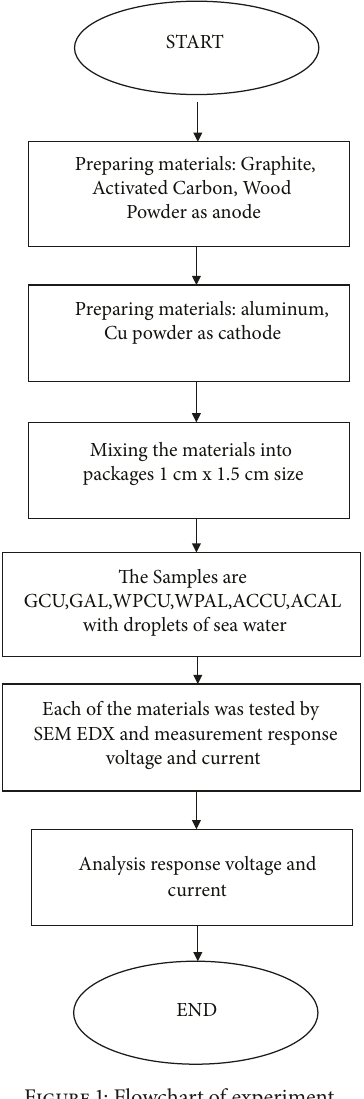
Figure 1: Flowchart of